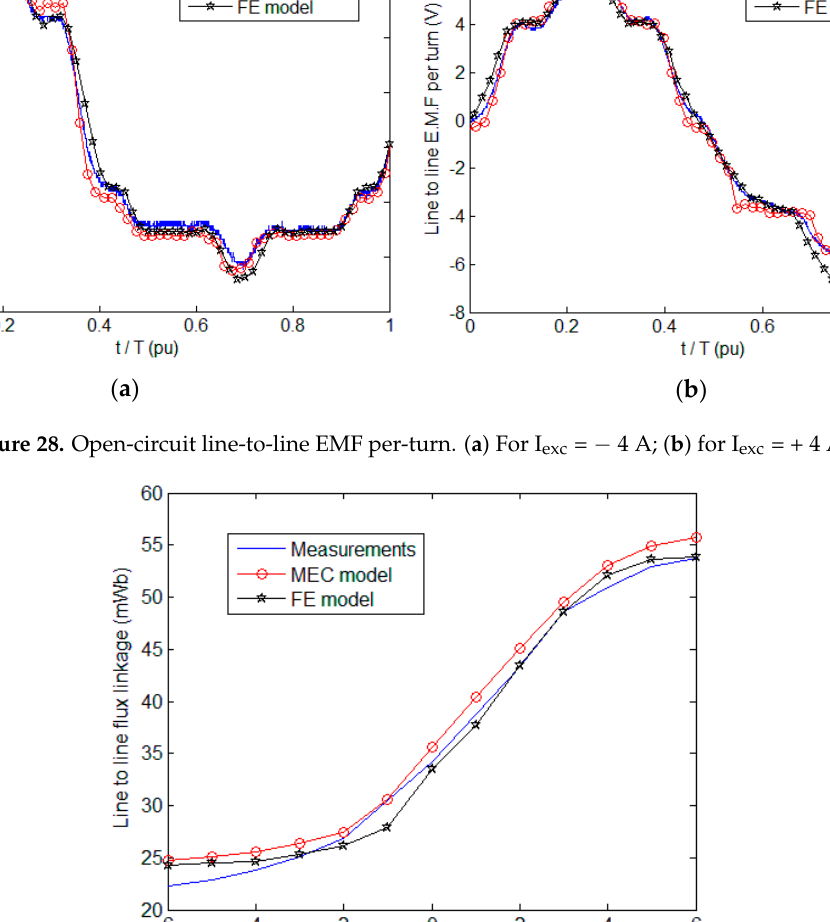
Figure 29. Open-circuit line-to-line maximum flux linkage variations with I exc .